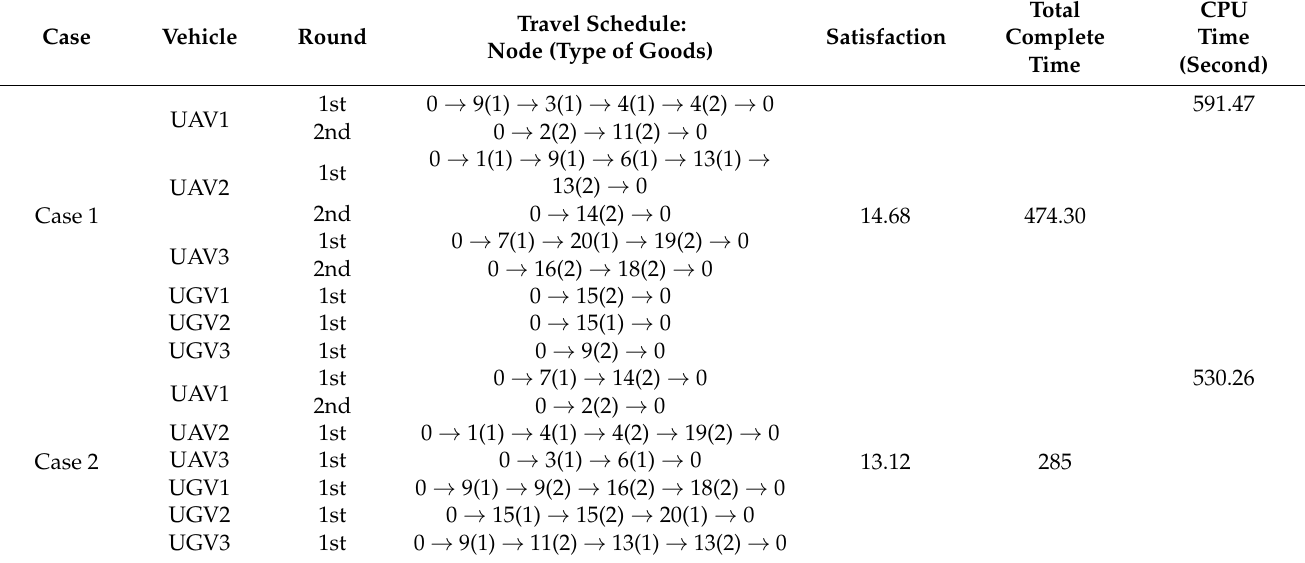
Table 6. The result of reasonable size